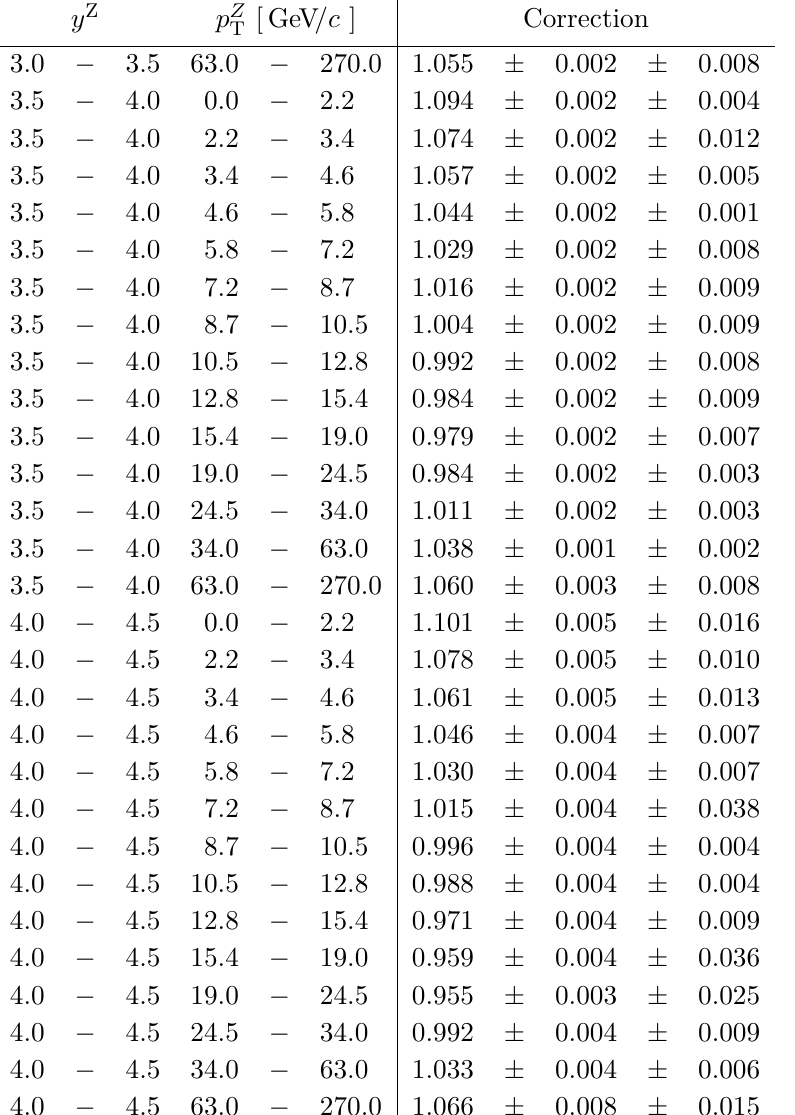
double cross-section measurement. T